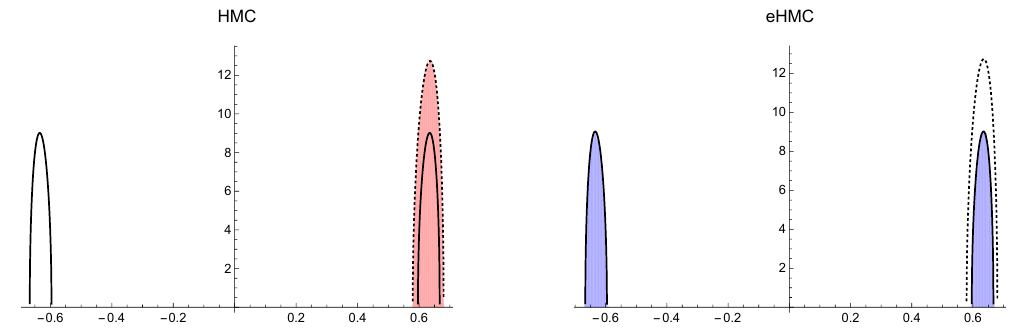
Figure 2 . Eigenvalue distributions for the system with the action defined in (2.1) with N = 100 , b = − 400 and c = 100 produced using approximately 2000 configuration (HMC) and approximately 1500 configurations (eHMC) with a similar acceptance rate and simulation running time. The dotted line shows the analytical result for the single-cut asymmetric solution, which is thermodynamically disfavoured (the false vacuum), while the solid line shows the preferred symmetric two-cut